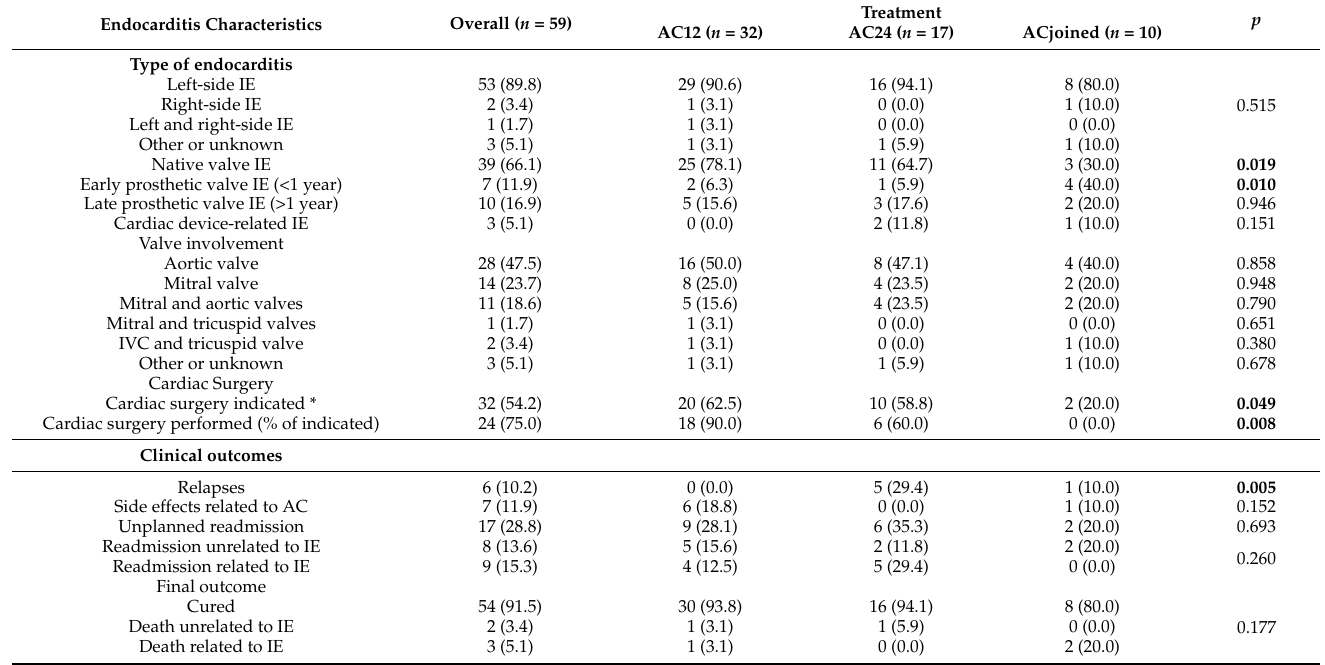
Table 2. Infection-related characteristics and clinical